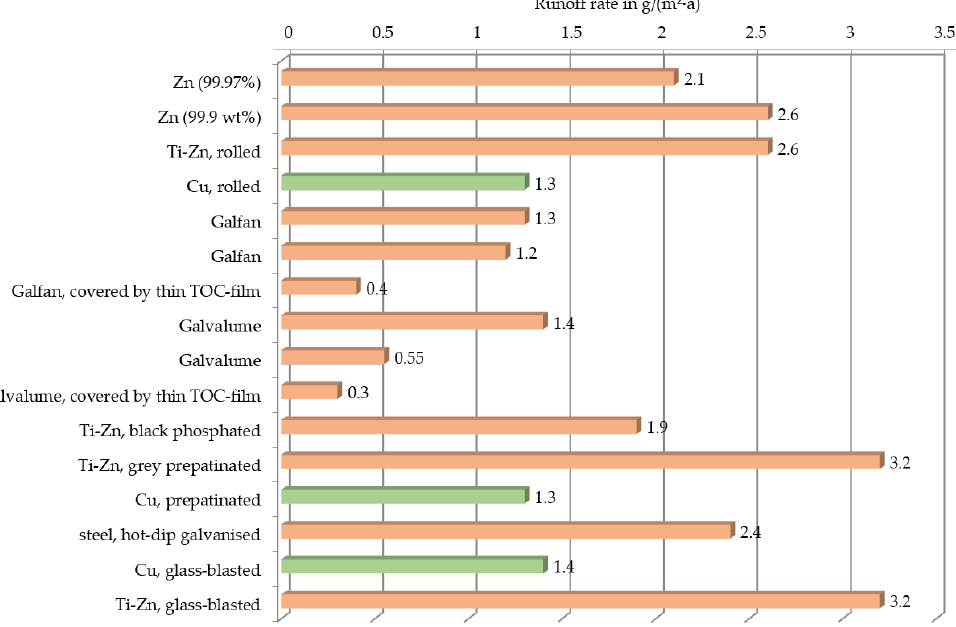
Figure 1. Overview of various runoff rates for different roof materials, different values for the same roof materials result from different test conditions (data according to [15